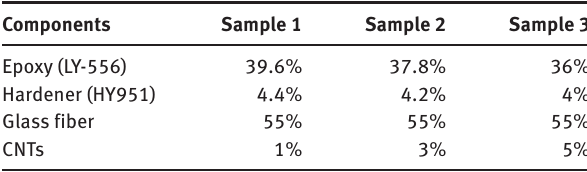
Table 1: Composition of nano glass fiber reinforced